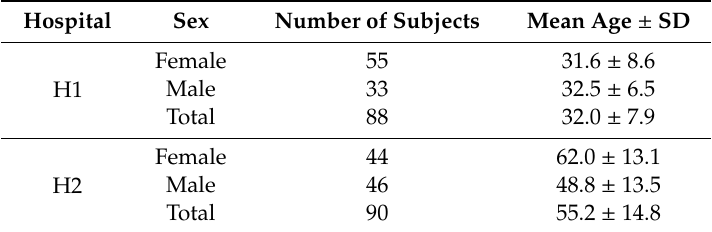
Table 2. Participants’